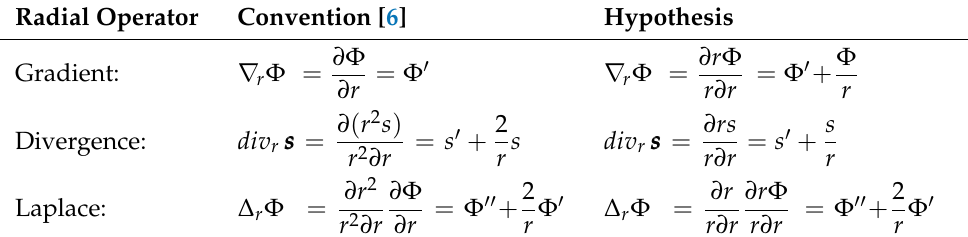
Table 3. Comparison of conventional and hypothetical spherical operators ∇ r Φ , div r sss and ∆ r Φ . For gradient and divergence operators the calculated results of the convention and the hypothesis misalign. Only for the Laplace operator both concepts provide the same result ∆ r Φ = Φ (cid:48)(cid:48) + 2 Φ (cid:48) / r